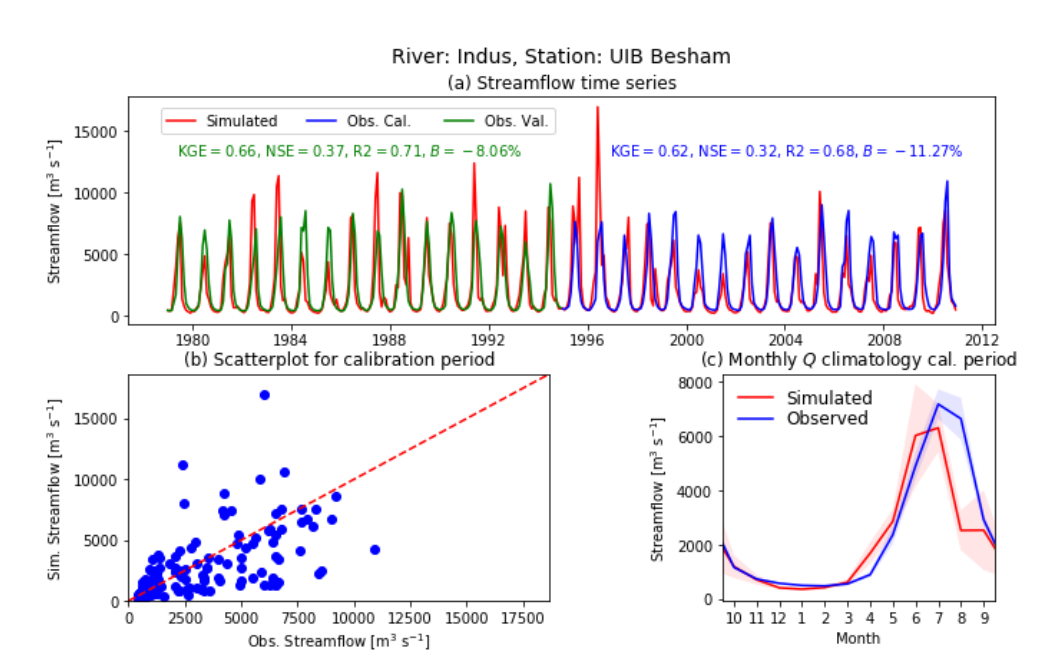
Figure 6. Comparison between the simulated streamflow by the calibrated model and the observation. KGE: Kling–Gupta efficiency. NSE: Nash–Sutcliffe efficiency. R2: R 2 . B: mean